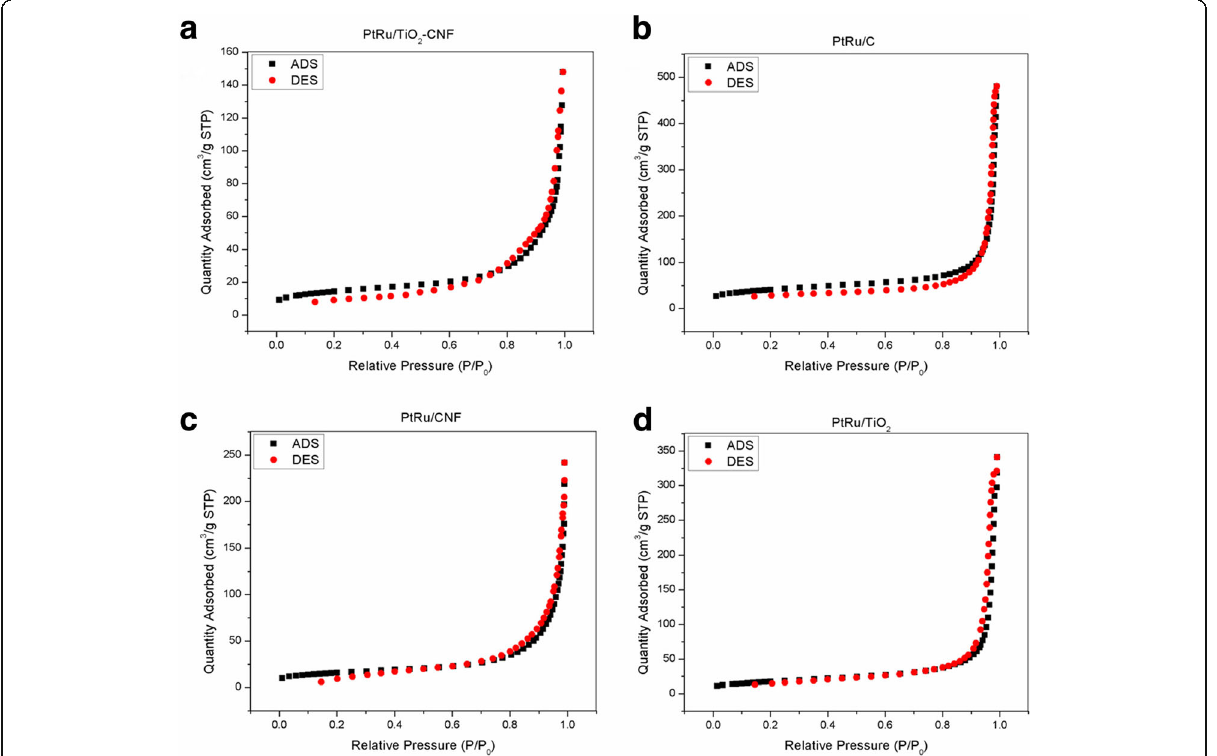
Fig. 2 Nitrogen adsorption (ADS) and desorption (DES) isotherm at 77 K. a PtRu/TiO 2 -CNF, b PtRu/C, c PtRu/CNF, and d PtRu/TiO